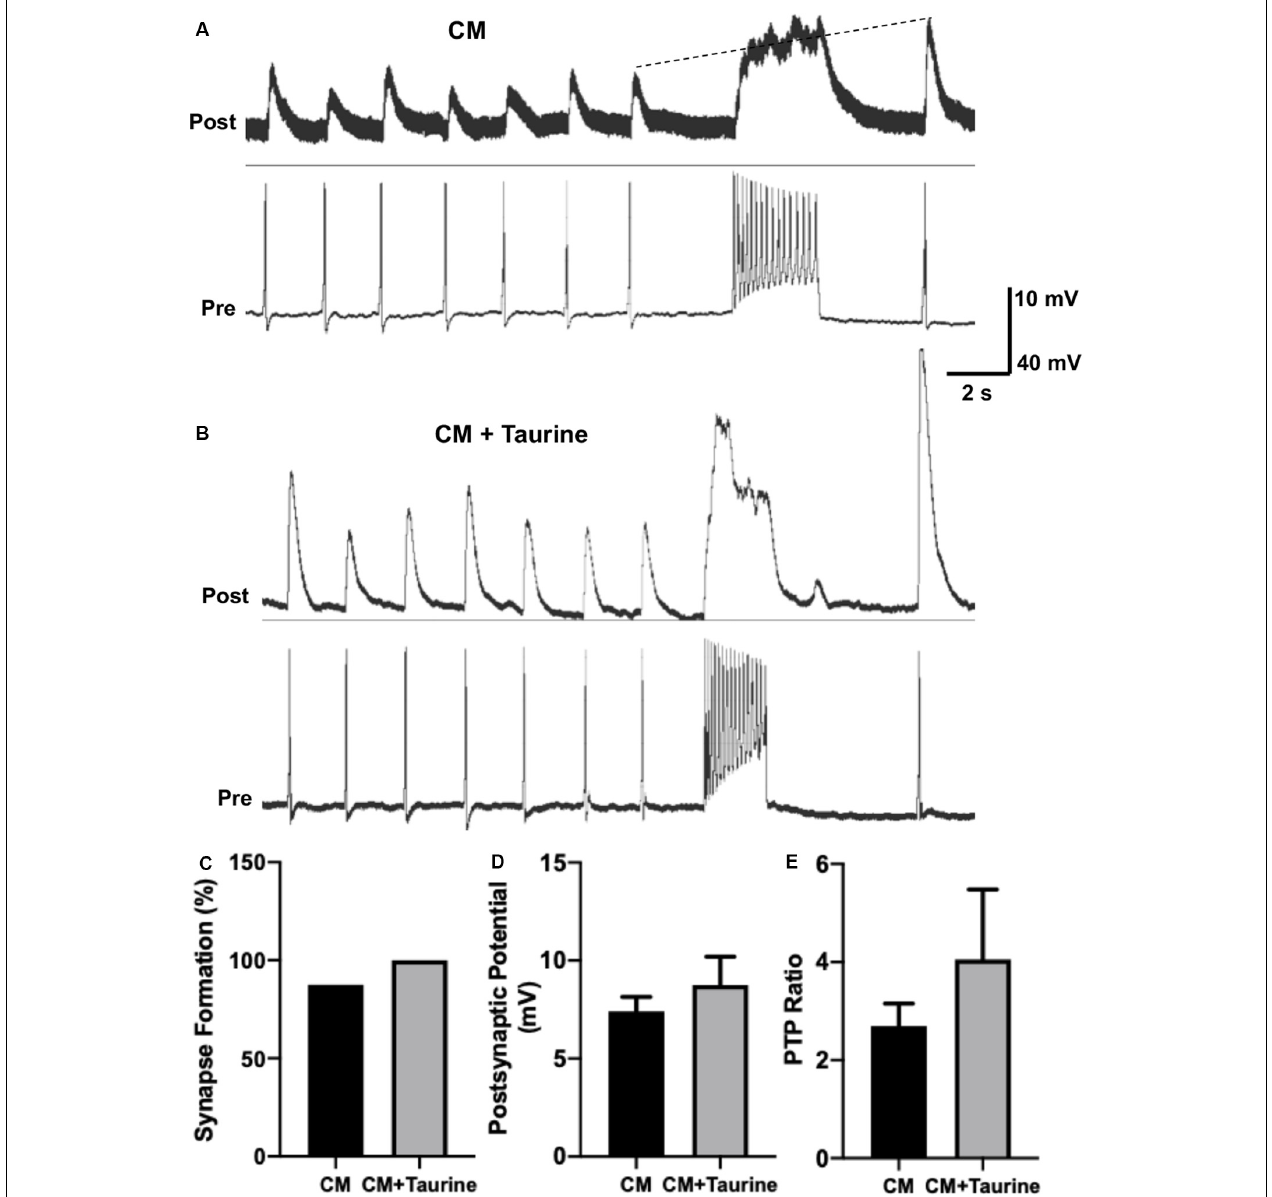
FIGURE 7 | Taurine nonsignificantly increases L. stagnalis neuron synapse formation, transmission, and plasticity in medium rich with trophic factors. L. stagnalis neurons were paired in a soma-soma configuration and cultured in medium containing L. stagnalis derived neurotrophic factors in Lymnaea brain conditioned medium (CM) alone or CM plus 1 mM taurine (CM + taurine). Intracellular recordings were made from the cell pairs. (A,B) Representative recordings show the responses of L. stagnalis cell pairs cultured in CM alone or CM + taurine. (C) Incidence of synapse formation was calculated as the percentage of cell pairs forming a 1:1 ratio of presynaptic action potential to postsynaptic PSP; cells cultured in CM + taurine formed strong synapses in all the pairs (100%) examined, while 87.5% of the pairs formed synapses in CM alone ( n = 5 for CM and n = 8 for CM + taurine; Fisher’s exact test, p = 1). (D) Average peak amplitudes of PSPs of cells cultured in CM + taurine was increased compared to cells cultured in CM alone. PSP in CM cultured cells was 7.40 ± 0.74 mV while PSP in CM + taurine cultured cells was 8.75 ± 1.44 mV ( n = 7 for CM and n = 5 for CM + taurine; student t -test, p = 0.4107). (E) The ratio of postsynaptic potential before and after tetanic stimulation (PTP ratio) was larger in pairs cultured in CM + taurine than those cultured in CM alone, although this was not significant. PTP ratio for CM was 2.69 ± 0.46, and PTP ratio for CM + taurine was 4.05 ± 1.43 ( n = 7 for CM, and n = 5 for CM + taurine; student t -test, p = 0.4069). The dotted line in (A) shows the increase in pPSP after high-frequency